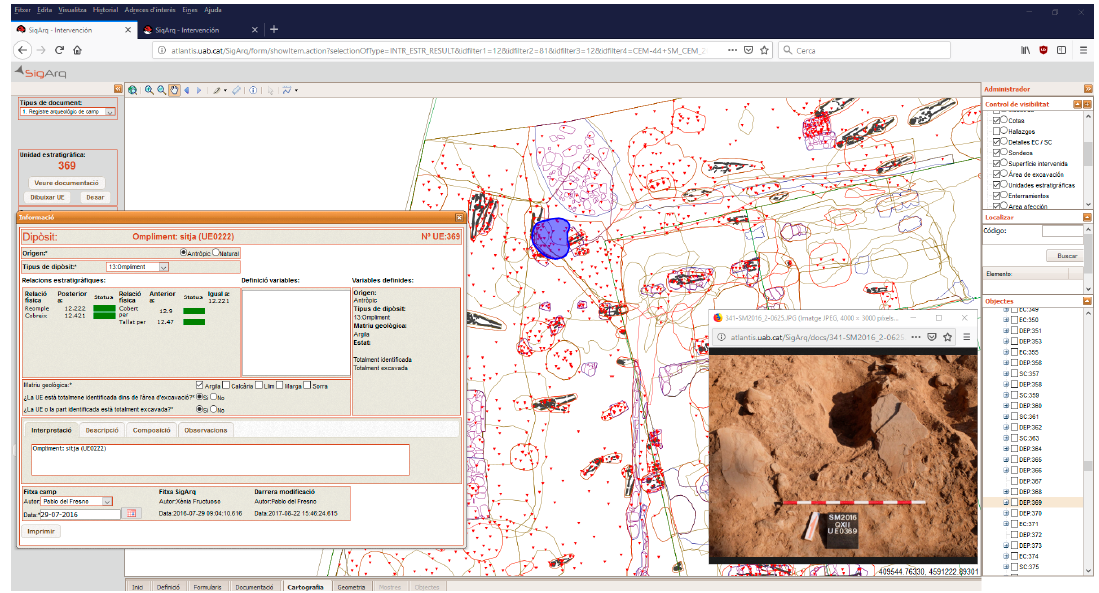
Figure 7. SigArq screen-view. At the end of the data recording process—as per US 369 in this figure—all four informative dimensions can be displayed at once for further exploitation.